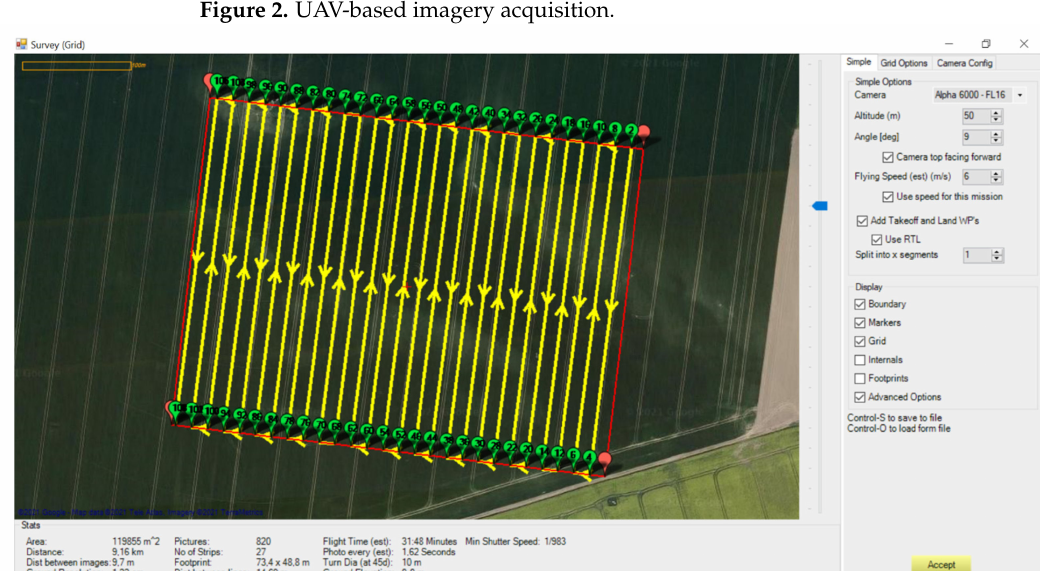
Figure 2. UAV-based imagery acquisition.